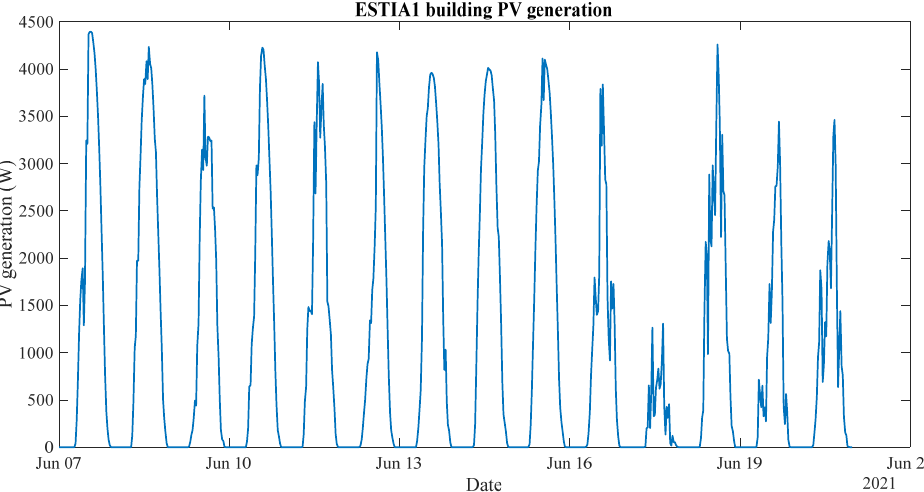
Figure 2. ESTIA1 PV generation for two weeks in June.